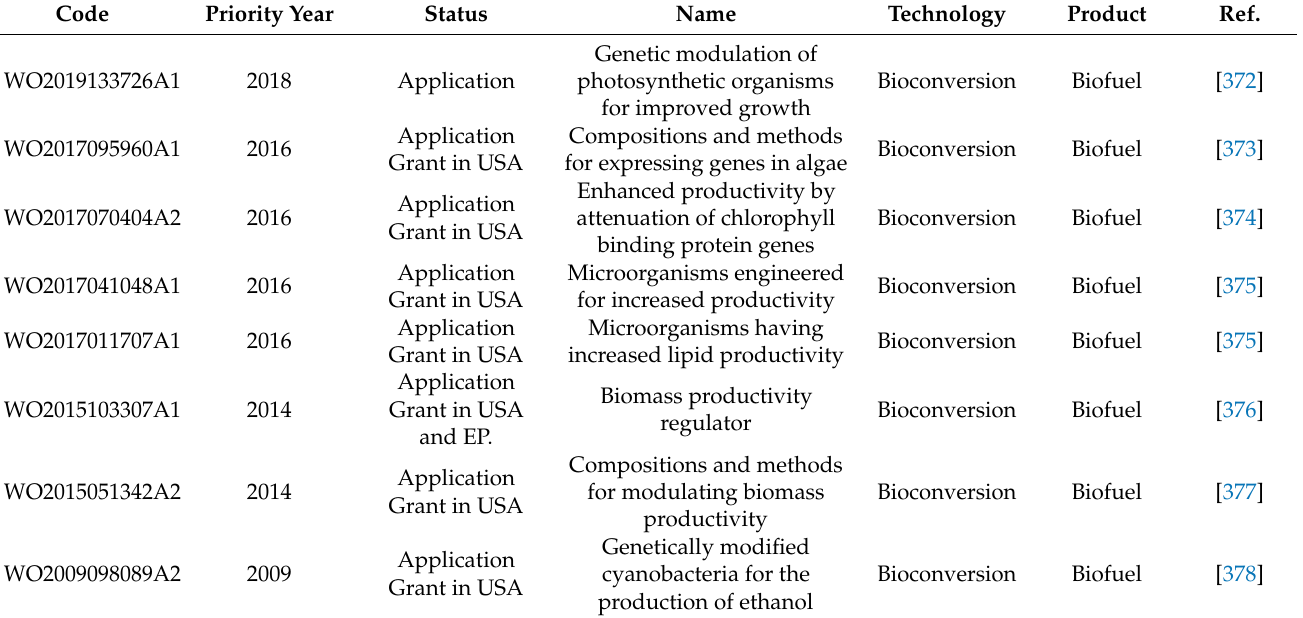
Table 14. Patents related to bioconversion and deposited by Synthetic Genomics,